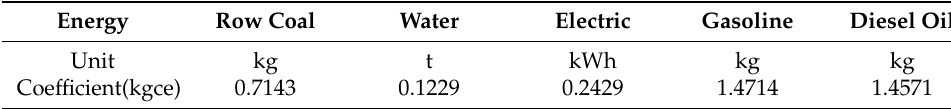
Table 3. Coefficient of main energy conversion standard coal.